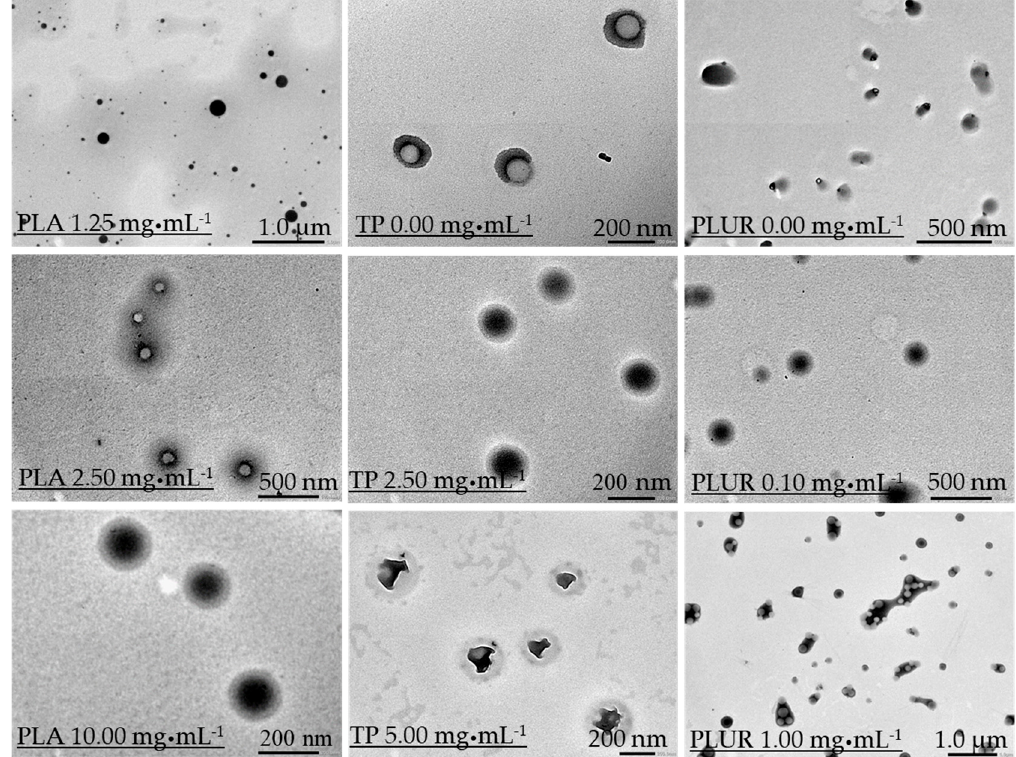
Figure 2. Representative TEM images of the TP-containing PLA NPs using different component concentrations (PLA: 1.25–10.0 mg·mL − 1 ; TP: 0–5.0 mg·mL − 1 and PLUR: 0–1.0 mg·mL − 1 ).